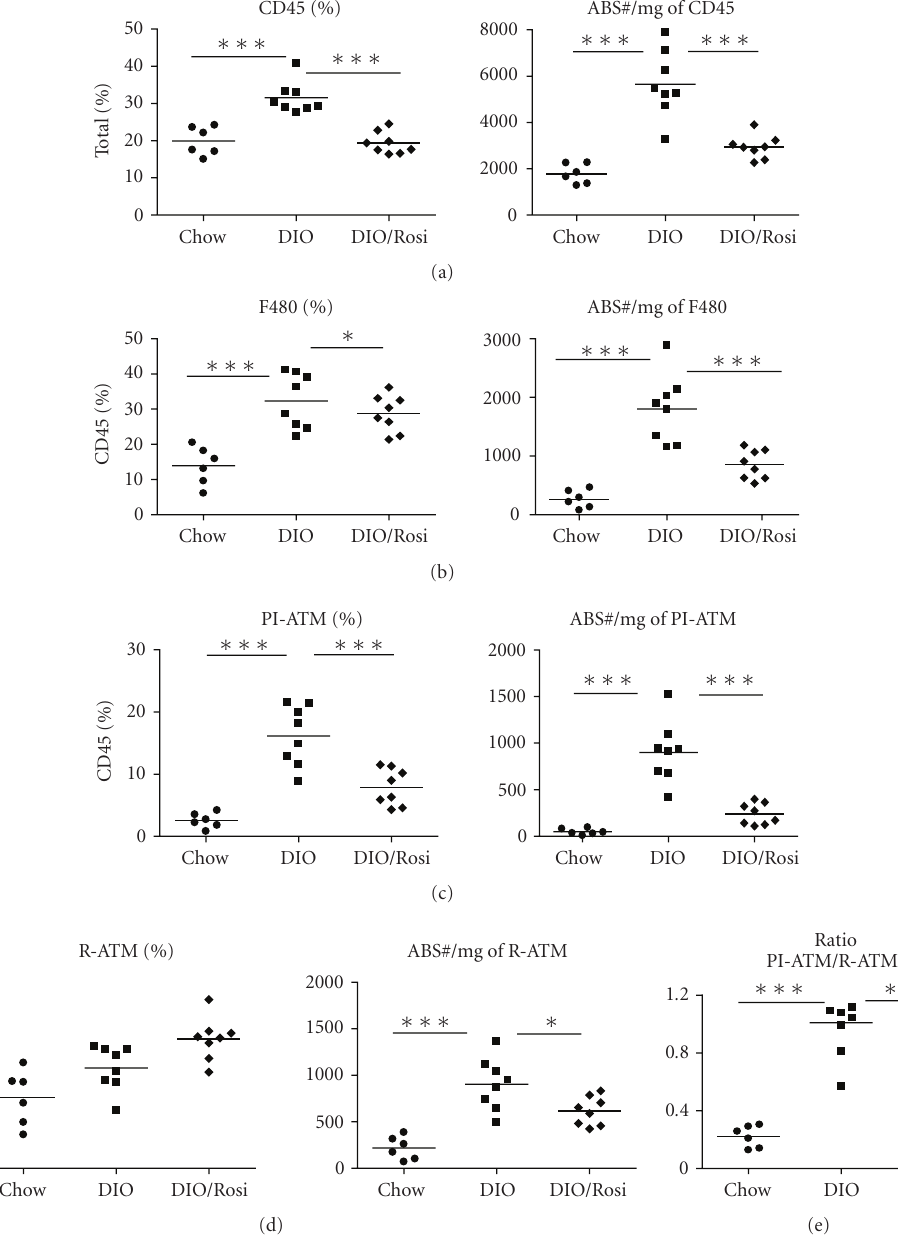
Figure 5: Rosiglitazone reduced the pro-inflammatory ATM infiltration in epididymal fat. Animals were put on Chow or an HF/CH diet for 12 weeks. Then Rosiglitazone at 5mg/kg or vehicle was supplemented in the food for drug treatment the final 6-weeks. (a)–(d). Flow cytometry was performed at the termination of the study at 18 weeks ( n ≥ 6 mice/group). (a) Total leukocyte infiltration was assessed by CD45. (b) Total macrophage infiltration was determined by CD45+F480+CD11b+ cells. Finally total macrophages were subdivided into two groups the (c) pro-inflammatory CD45+F480+CD11b+CD11c+ ATMs and (d) resident CD45+F480+CD11b+CD11c ATMs. (e) The ratio of the pro-inflammatory ATMs to resident ATM populations was reduced with Rosiglitazone. Values represent the mean and SEM. The groups are represented by the following symbols: circles (Chow), squares (DIO), and diamonds (DIO/Rosi). One way ANOVA (Bonferroni multiple comparison) was used to compare Chow to DIO and DIO to DIO/Rosi at each time point; ∗ P < . 05 and ∗∗∗ P < .